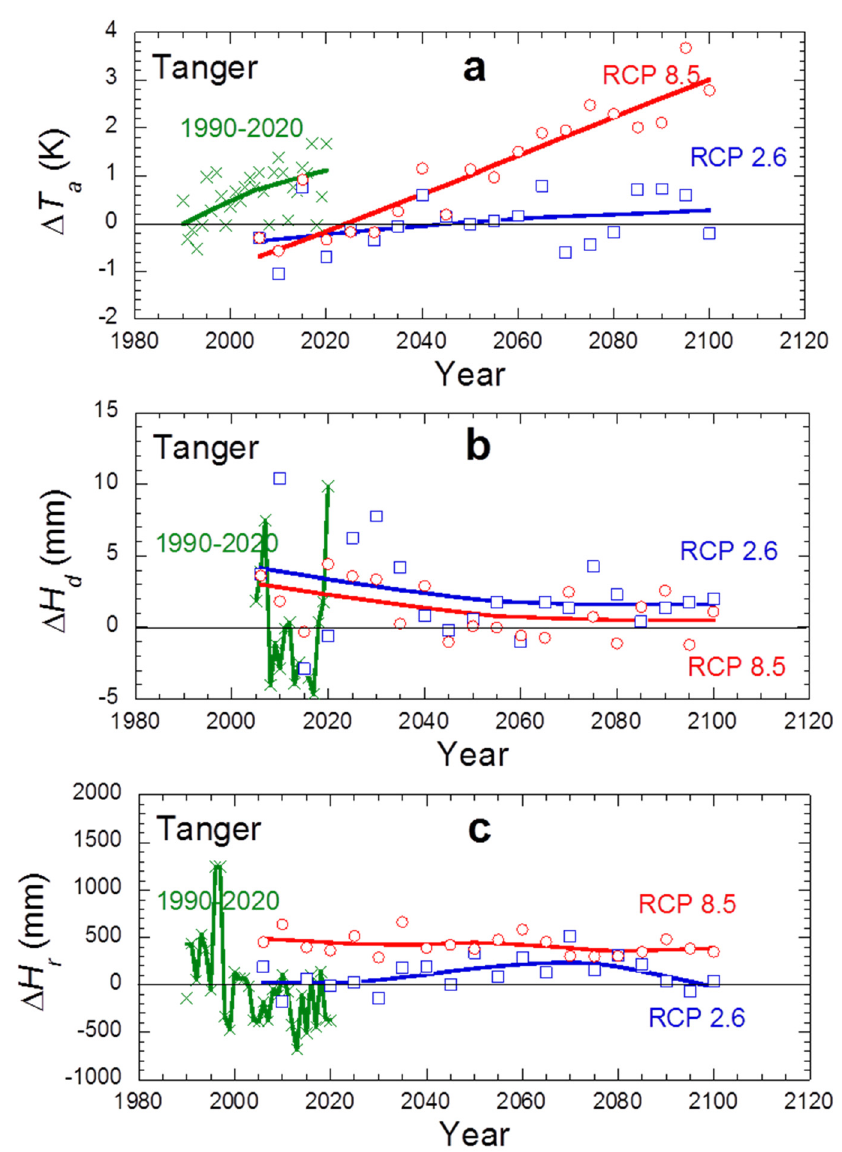
Figure 5. Predicted evolutions for Tanger (Morocco). Green crosses: Actual data of the difference with respect to the yearly mean value; blue squares: RCP 2.6 scenario; red circles: RCP 8.5 scenario. Curves are smoothened data. ( a ) Air temperature with respect to the 1980–1990 mean, ∆𝑇 (cid:3028) =